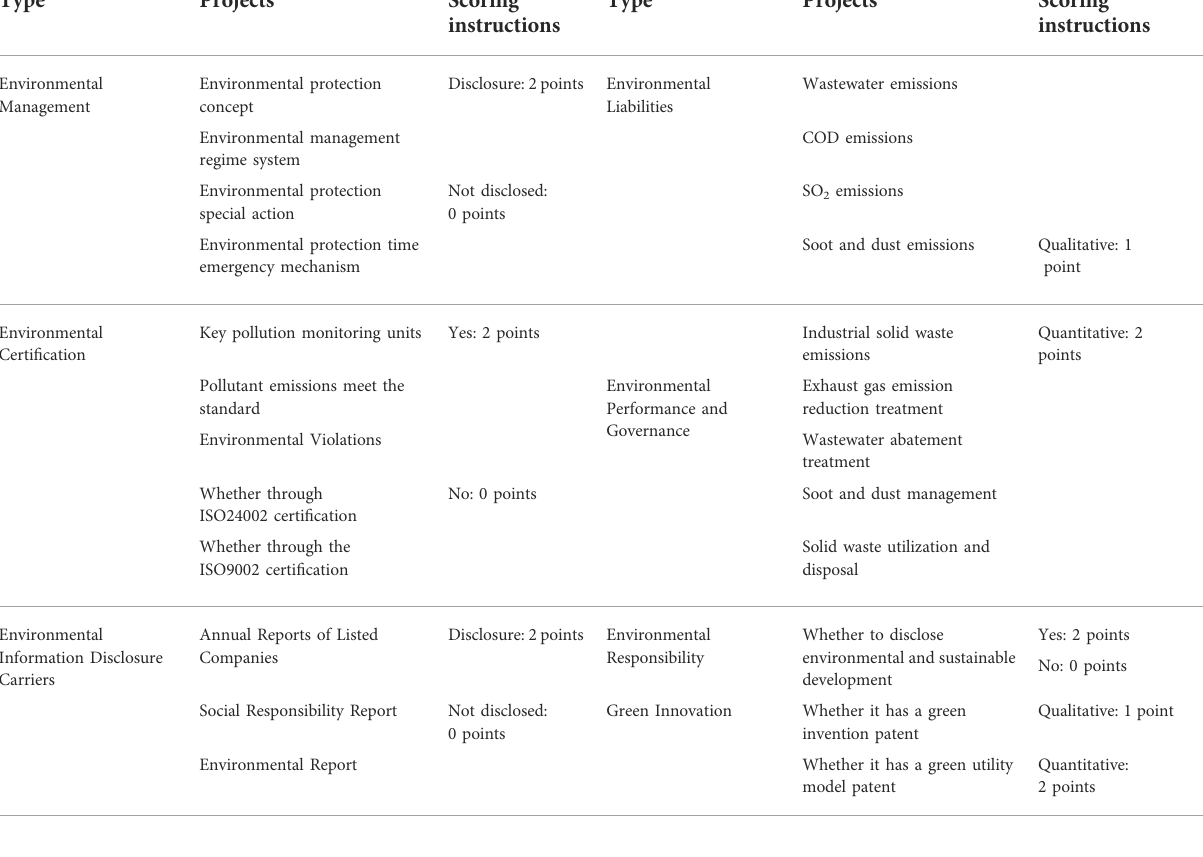
TABLE 1 The green transformation evaluation system.